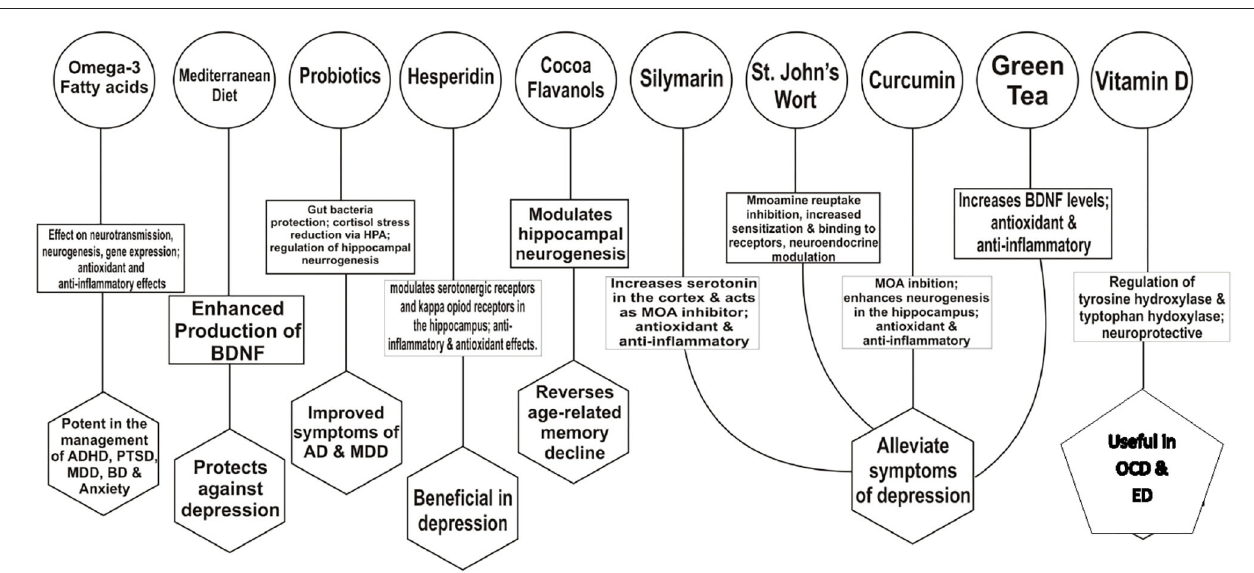
FIGURE 3 | Bio-molecular mechanisms of dietary interventions in some mental disorders. HPA, hypothalamic-pituitary-adrenal axis; OCD, Obsessive-Compulsive Disorder; MOA, Monoamine oxidase; BD, Bipolar disorder; BDNF, brain-derived neurotrophic factor; MDD, Major Depressive Disorder; ADHD, Attention deficit hyperactivity disorder; PTSD, Post traumatic stress disorder; AD, Alzheimer dementia; ED, Eating